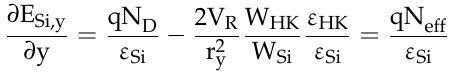
where r y is the depth of the vertical depletion region. W Si and W HK are the widths of the semiconductor and HK dielectric, respectively. In order to obtain a uniform vertical electric field, HK trench layers with different dielectric constants are designed according to the semiconductor doping concentration under the drain. The doping concentration of the N+ pillar junction and the N-type buffer layer near the drain end is high, and there is a junction curvature effect, thus a relatively high dielectric layer is needed at the top of the trench to weaken the peak electric field under the drain. However, the doping concentration of the substrate is low, thus a relatively low HK dielectric is at the bottom of the trench. Additionally, because of the change of the K value, a new electric field peak appears to modulate the vertical electric field of the device, thereby achieving the purpose of optimizing the vertical electric field distribution of the device. Under the conditions of the avalanche breakdown, the theoretical BV of VHK SJ-LDMOS is obtained by the integral of the lateral and vertical E-field component